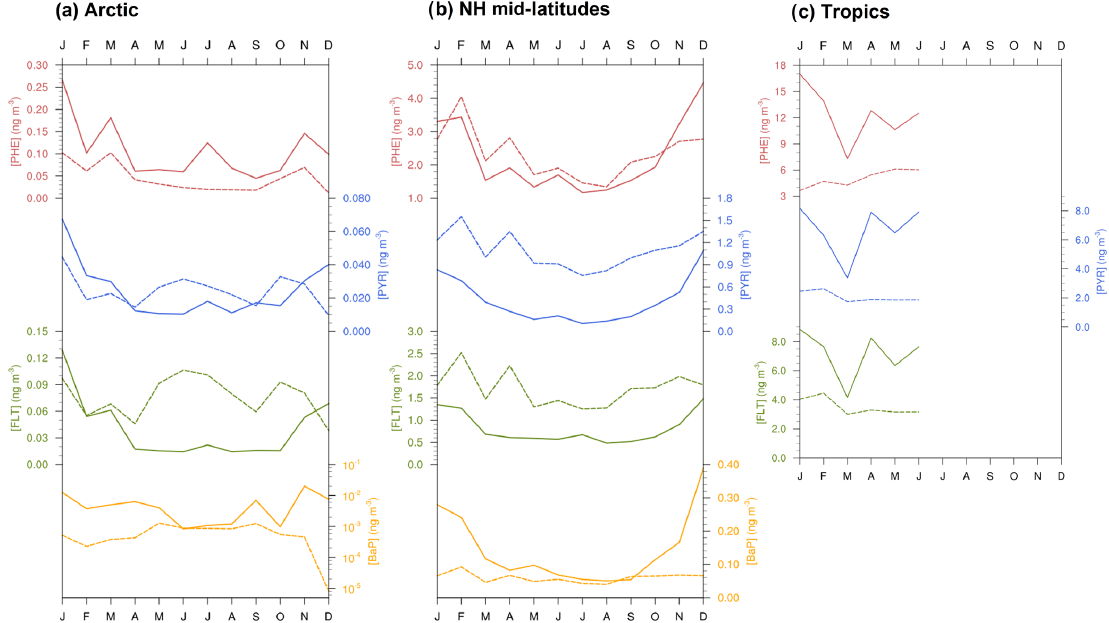
Figure 5. Seasonal mean total (gas + particle) concentrations of PAHs (ngm − 3 ) from observations (solid lines) and simulations (dashed lines) averaged over all stations in the (a) Arctic, (b) northern midlatitudes, and (c) the tropics. Note that a logarithmic scale has been used for BaP concentrations in the Arctic. Table 2. Statistics comparison of model simulation and observations of total (gas + particle) concentrations of PAHs from stations in the Arctic, northern midlatitudes, and the tropics. N : Number of observed-simulated monthly data pairs; x : mean; Q2 x : median; SD x : standard deviation; GM x : geometric mean; x : simulated (M) or observed (O) data; MB: mean bias; RMSE: root mean square error; NMB: